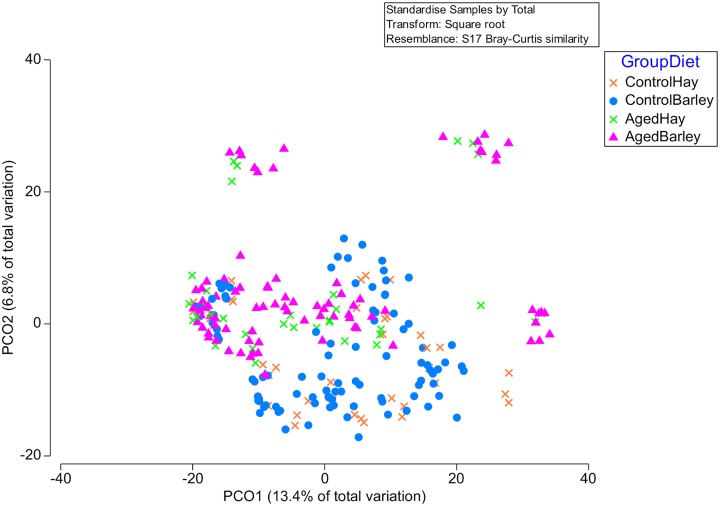
Principle coordinate analysis of the bacterial OTU data (excluding those OTU’s present at <0.01% relative abundance) by group and diet.